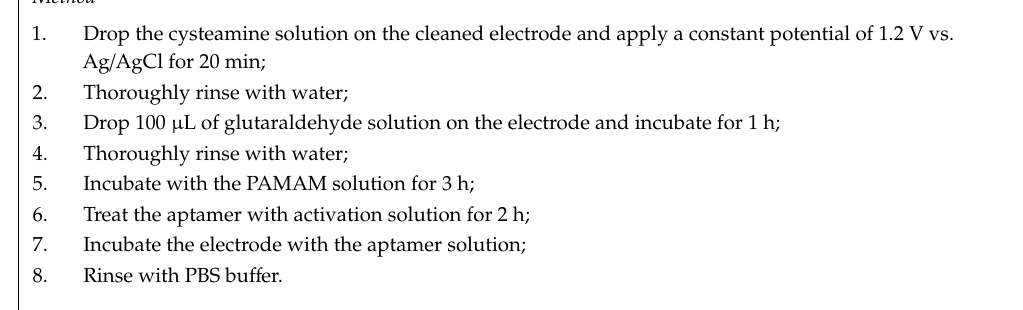
Protocol A7 by Cao et al. [13]: Dual-signaling strategy of aptamer-labelling with ferrocene and